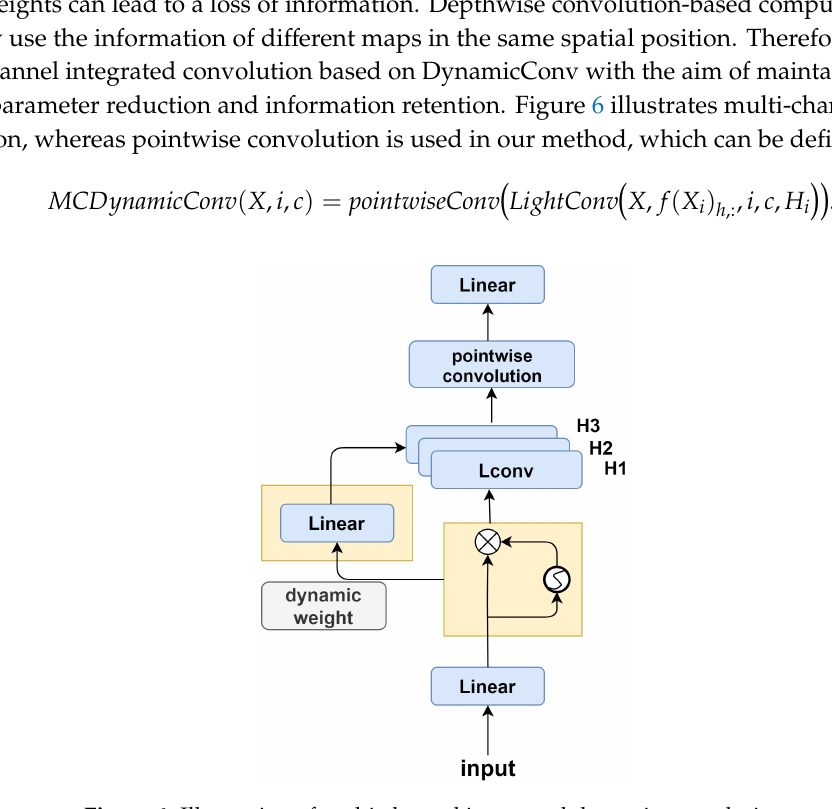
Figure 6. Illustration of multi-channel integrated dynamic convolutions.